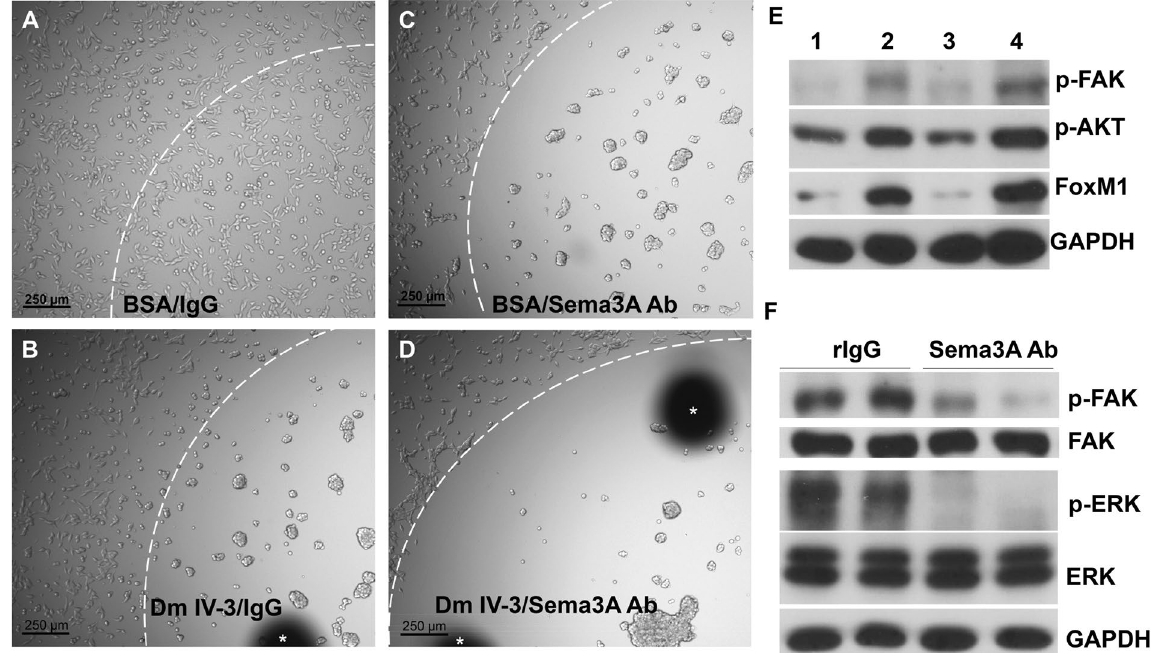
Figure 5. Semaphorin 3A (Sema3A) antibody imitates Domain IV-3 activity on prostate cancer cells. Cell culture wells were spotted with control BSA and rabbit IgG (panel A), Domain IV-3 and rabbit IgG (panel B), BSA and Sema3A antibody (Ab) (panel C), or Domain IV-3 and Sema3A antibody (panel D) (inside the white dashed arc line). C4-2 cells were seeded and imaged 24 hours later. Scalebar is 250 µ m. White asterisks indicate black fiduciary markers used to approximate the area of surface adsorbed substrate. ( B ) A western blot of C4-2 cells cultured for 24 hours on Domain IV-3 (lane 1), rabbit IgG (lane 2), Sema3A antibody (lane 3), or control BSA (lane 4). ( C ) Western blot of C4-2 cells cultured for 24 hours on control rabbit IgG or Sema3A antibody and probed for p-FAK, FAK, p-ERK, ERK1/2, and GAPDH. The Sema3A antibody as a substrate produces results akin to Domain IV-3 for C4-2